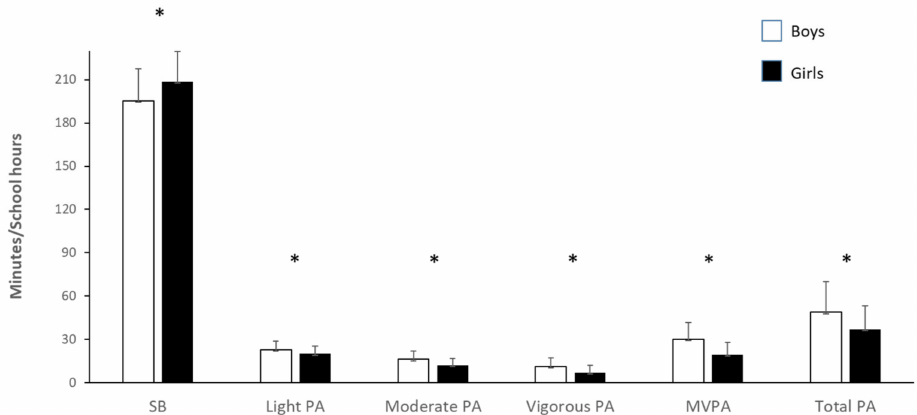
Figure 1. Categories of physical activity during school hours based on gender. SB, sedentary behaviour; LPA, light physical activity; MPA, moderate physical activity; VPA, vigorous physical activity; MVPA, moderate to vigorous physical activity; Total PA: light, moderate, or vigorous PA. * p < 0.05 between boys and girls.